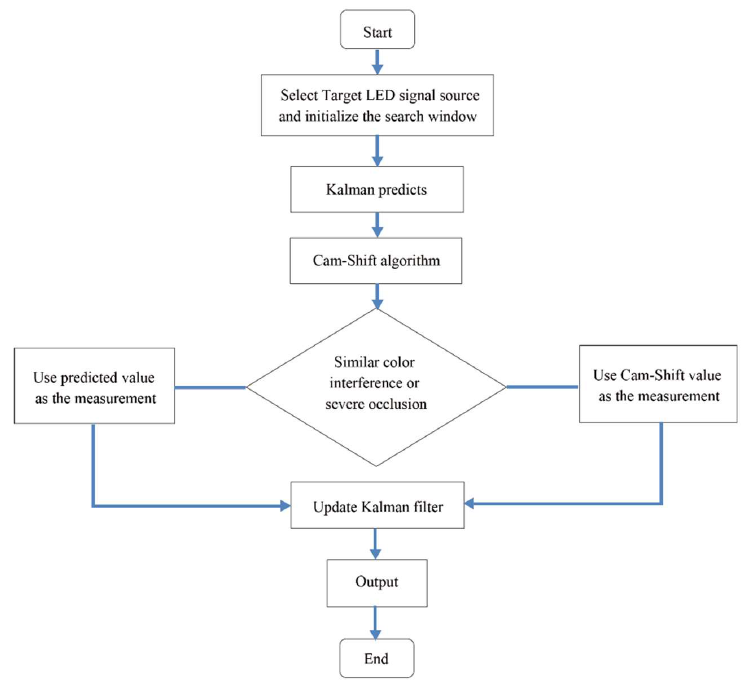
Figure 6. Detailed procession of the proposed tracking algorithm.